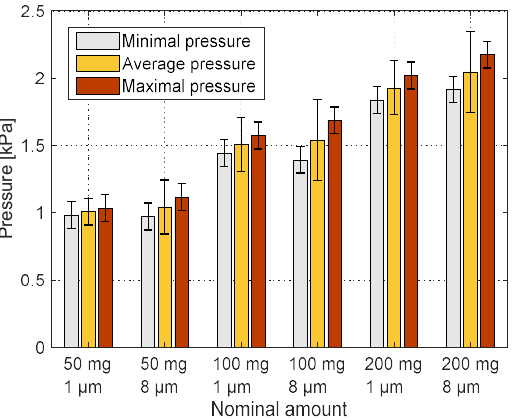
Figure 15. Comparison between the pressure results of 1 and 8 μm particles.